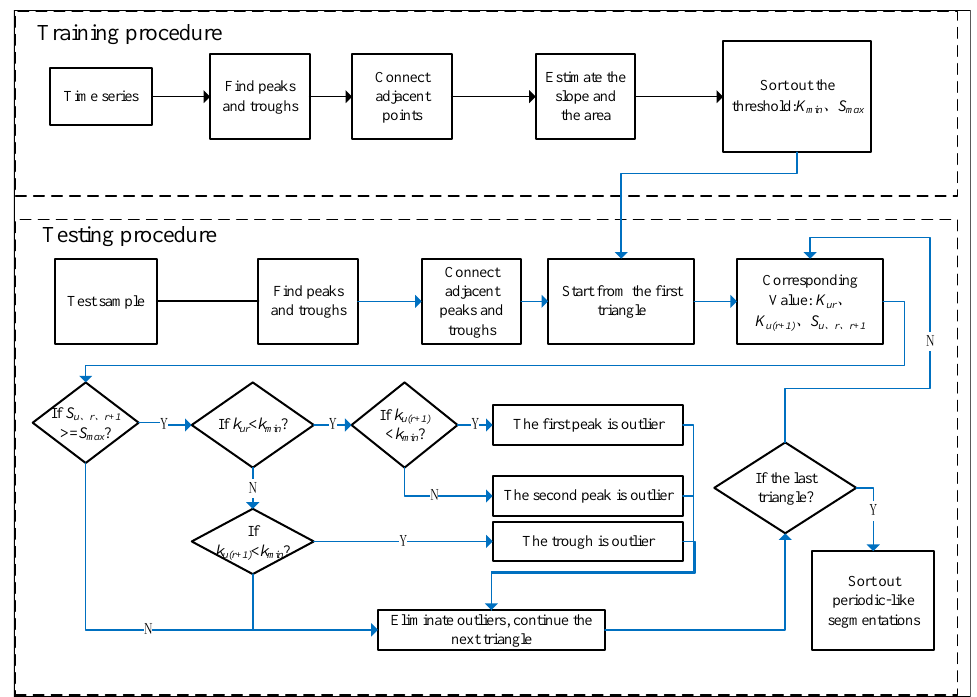
Figure 7. The flow chart of the proposed SA algorithm. } and P } be the set of peak and = { P 1 Let P v = { p 1 , p 2 , p 3 , . . . , p m , P 2 , P 3 , . . . , P n c v v v v c c c c trough points in the periodic-like segmentations in the training sample, respectively. Here, m and n are the number of peak and trough points, respectively. Suppose k ur and L ur are the absolute value of the slope and the length of the line connecting between the peak point ( p r ) and the trough point ( p u ), respectively. Similarly, k and L are the v c u ( r + 1 ) u ( r + 1 ) absolute value of the slope and length of the line connecting between the peak point ( p r + 1 ) v < P u < P r + 1 and the trough point ( p u ) . Here, P r , 1 ≤ u ≤ n , 1 ≤ r < m . It is necessary c v c v to calculate the area of the lines connecting three points, p u , p r + 1 , and p r , where the c v v × sin a , and a is the angle of the lines connecting L ur × L triangle area is S u , r , r + 1 = 1 u ( r + 1 ) 2 three points, as shown in Figure 8. The slope of point p u and p r , k ur can be obtained as c v shown in Equation (7). Here, x p r and y p r represent the corresponding number of sampling v v points and the acceleration value of point p r , respectively. Let 1/ k ur and 1/ k be v u ( r + 1 ) the tangent values of ∠ 1 and ∠ 2. The tangent values of ∠ a can be obtained, as shown in Equation (8). According to tan a obtained above, the corresponding sin a can be obtained using Equation (9). Then the triangle area, S u , r , r + 1 can be calculated by Equation